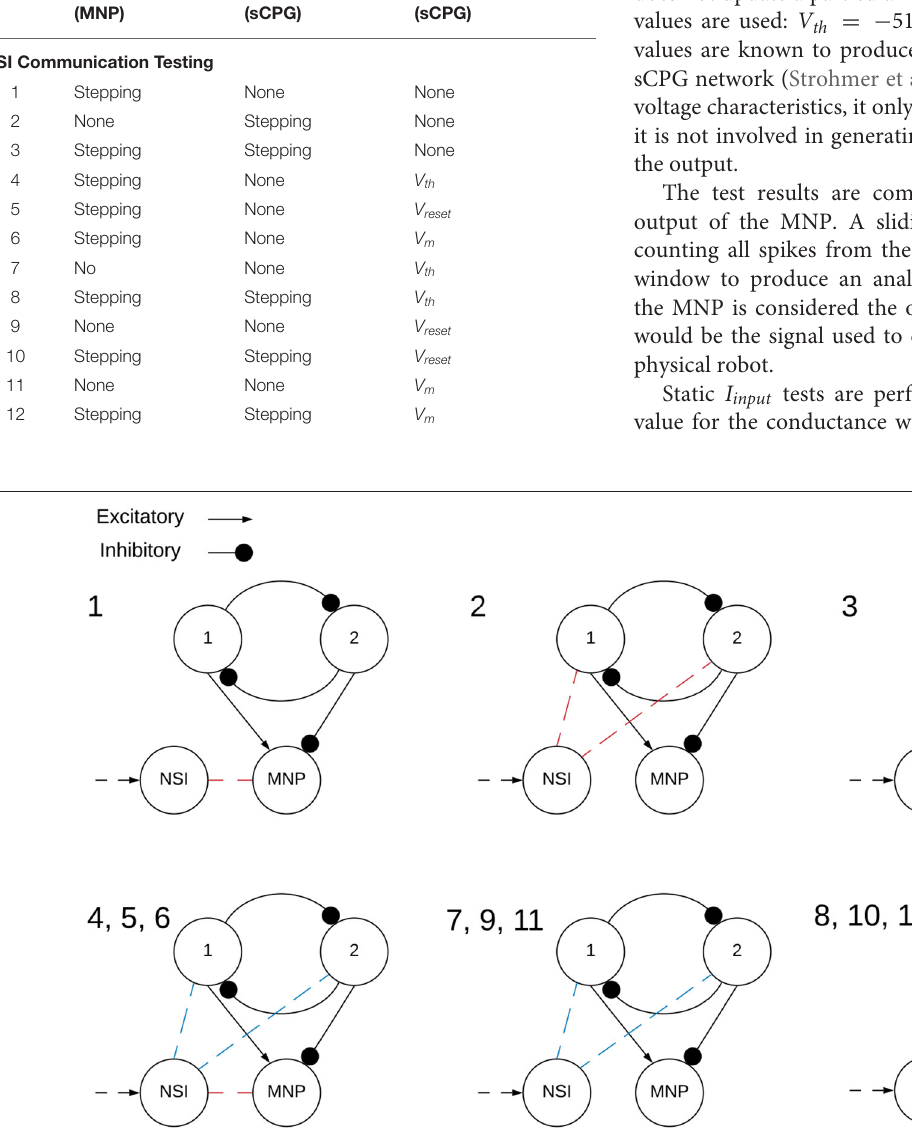
FIGURE 4 | Visualization of NSI communication testing outlined in Table 1 . Red indicates a current injection and blue indicates a voltage characteristic manipulation. Input bias current to the NSI is always excitatory (black dashed arrow). The numbers indicate the main test number corresponding with the depicted setup.